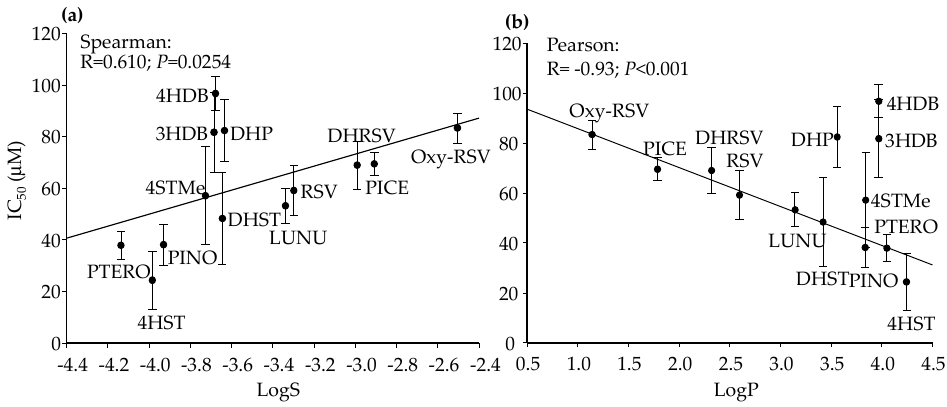
Figure 8. IC 50 values dependence on LogS ( a ) and LogP ( b ) in HT-29 cells after 72 h. Pearson correlation values were calculated excluding DHP, 3HDB, and 4HDB in ( b ). Values are shown as mean ± SD (n = 3).